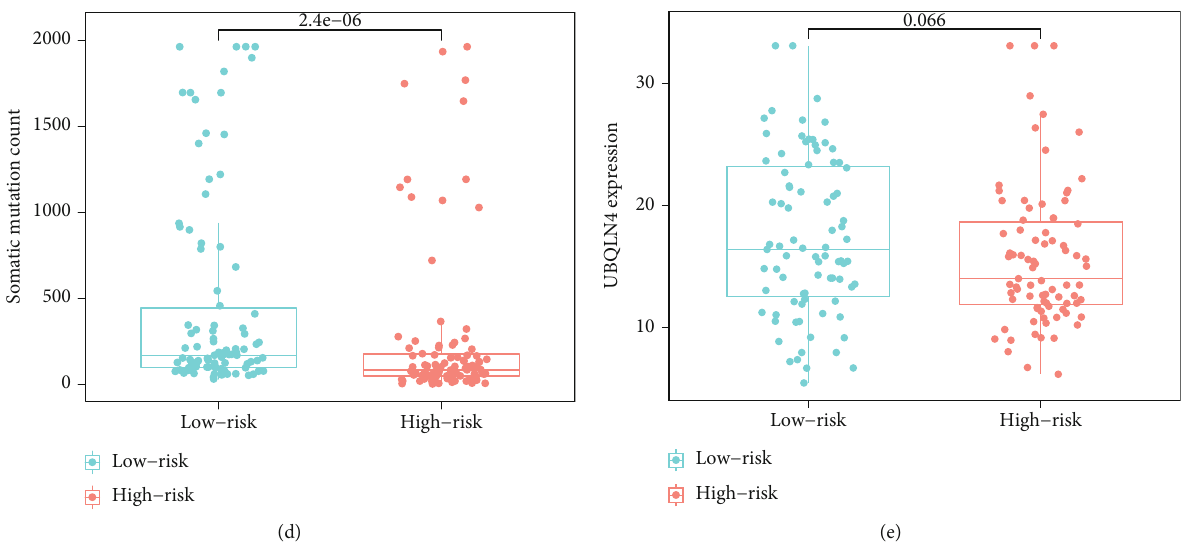
Figure 2: Patient characteristics in the high- and low-risk groups in the training set. (a) Survival distribution of high- and low-risk patients. (b) ROC curves predicting 1-, 3-, and 5-year survival rates. (c) Expression of the 8 miRNAs changed with increasing risk score. Comparisons of somatic mutation count (d) and UBQLN4 expression (e) in the high- and low-risk